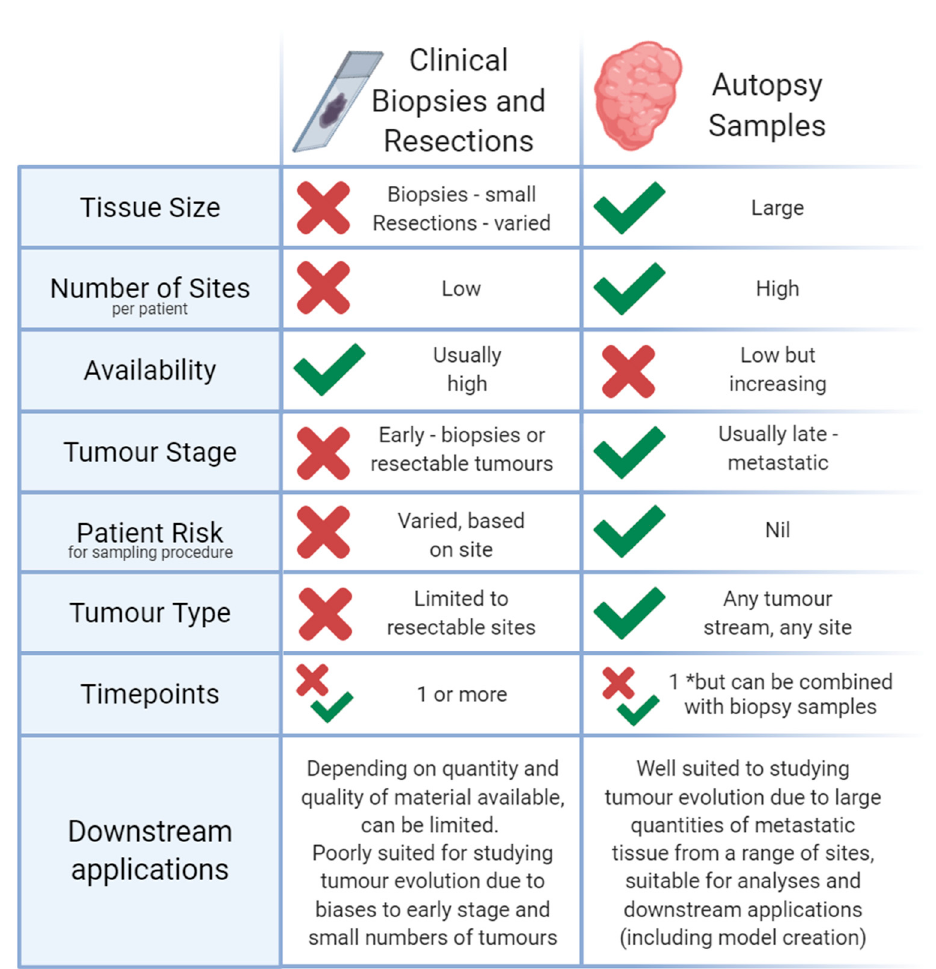
Figure 2. Comparison of tissue samples collected through clinical care (including biopsies and resections) with those collected at autopsy after the patient’s death. Autopsy samples are better suited to answering many questions in cancer evolution than those collected through clinical care, because of the availability of larger volumes of metastatic tissue from a variety of sites from the same patient, however clinical samples are more readily available to researchers in many parts of the world at this time (although the increase in autopsy programmes is notable), and provide information on different timepoints of disease, including before and after treatment, and are thus particularly valuable when used alongside autopsy tissues in cancer evolution studies.